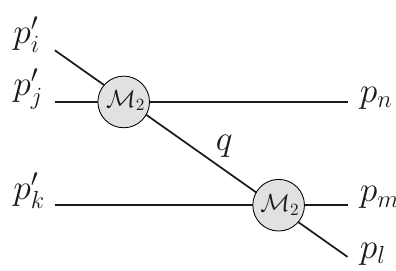
Figure 2. The most singular contribution to the relativistic three-body scattering amplitude. The four-momentum q = p 0